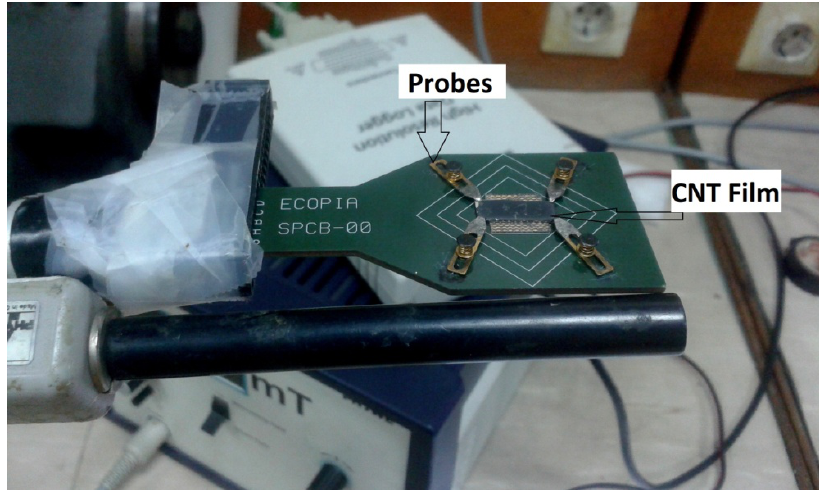
Figure A3. four probes on the CNT film. Figure A3. Four probes on the CNT film.